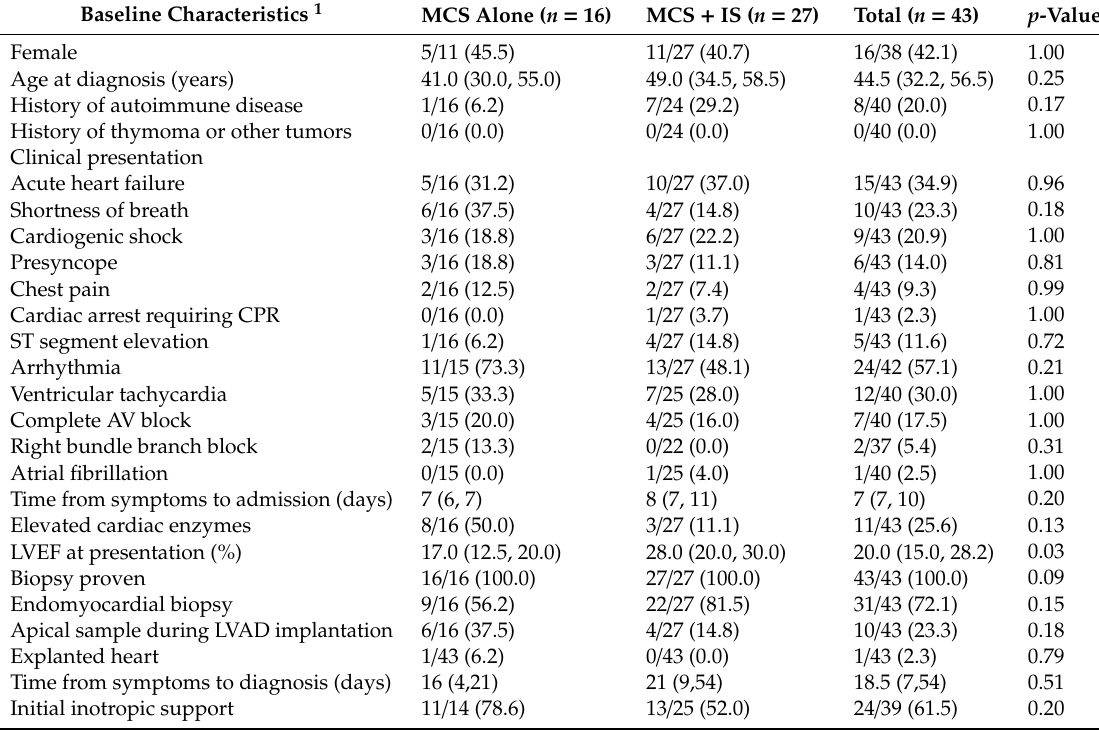
Table 1. Baseline characteristics of patients with giant cell myocarditis (GCM) supported with mechanical circulatory support (MCS) alone or in combination with